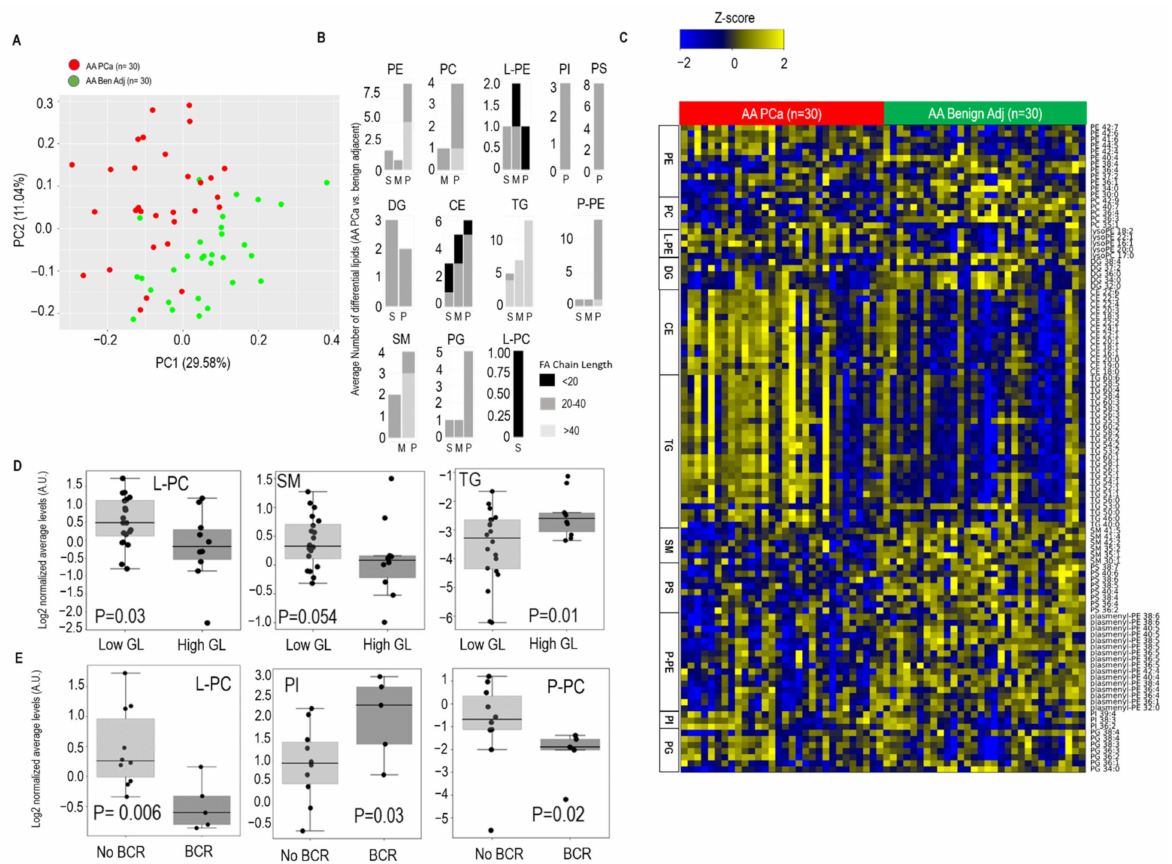
Figure 1. Altered lipidome in AA PCa vs. matched benign adjacent prostate tissue. ( A ) Principal component analysis using lipid profiles in 30 paired AA PCa and benign adjacent prostate tissues. ( B ) Number of altered lipids within each class stratified by fatty acid chain length (see legend) and degree of saturation. S: saturated, M: mono-unsaturated, P: poly-unsaturated ( ≥ 2 double bonds). ( C ) Heat map showing significantly altered lipids (stratified by fatty acid chain length: degree of saturation) in AA PCa vs. matched benign patient prostate tissues. Shades of yellow and blue represent up and down regulated lipids, respectively (see color key). Lipid classes are marked on the left side of the heatmap. Lipid classes include PE: Phosphatidyl ethanolamine, PC: Phosphatidyl choline, PI: Phosphatidyl inositol, PG: Phosphatidyl Glycerol, PS: Phosphatidyl Serine, L-PE: Lyso Phosphatidyl Ethanolamine, TG: Triglycerides, SM: Sphingomyelin, P-PE: Plasmenyl Phosphatidyl Ethanolamine, CE: Cholesteryl Esters, DG: Diglycerides, L-PC: Lyso phosphatidyl choline. ( D ) Average levels of L-PC ( p = 0.03) and SM ( p = 0.054) are significantly down-regulated, and average levels of TGs ( p = 0.01) are significantly elevated in high Gleason grade (High GL, n = 10) compared to low Gleason grade (Low GL, n = 20) tumors. ( E ) Average lower levels of L-PC ( p = 0.006) and P-PC (plasmenyl-phosphatidyl choline, p = 0.02) and elevated average levels of PI ( p = 0.03) are associated with biochemical recurrence (BCR, 5 years post-prostatectomy) in PCa patients. No BCR ( n = 10); BCR ( n = 5). For panels B and C, paired t -test followed by Benjamini Hochberg (BH) false discovery rate (FDR < 0.1) correction was used to compute differential analysis. For panels D and E, a Mann–Whitney test with BH FDR < 0.25 was used to compute statistical